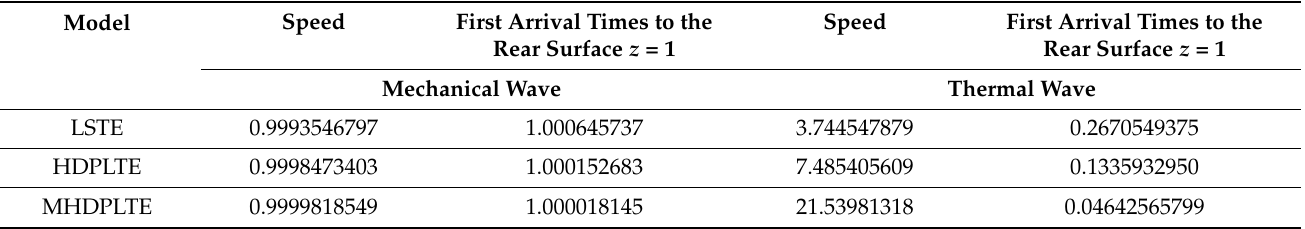
Table 2. Velocities and arrival/passage times for mechanical and thermal waves to the rear surface of the plate, z = 1, for different finite speed models.